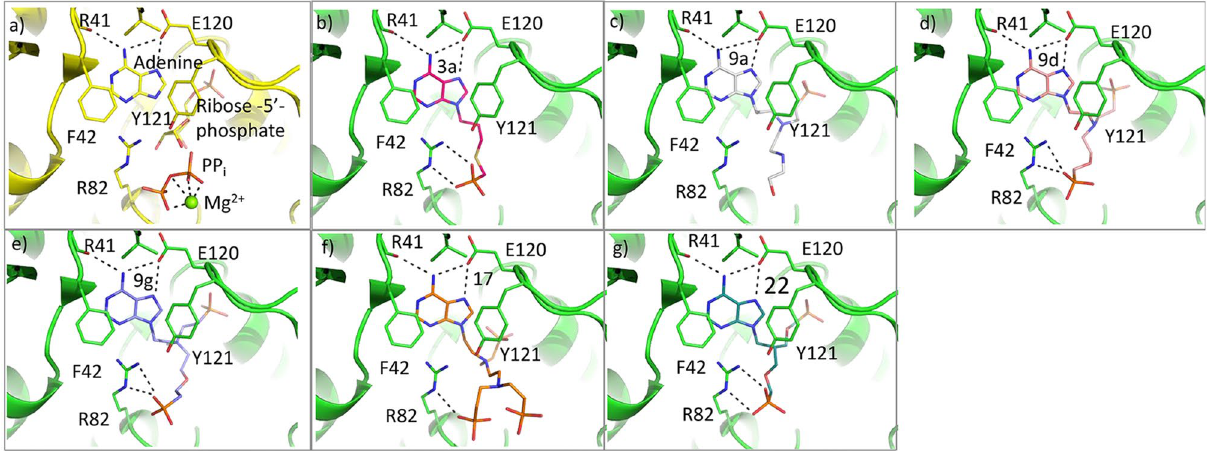
Figure 5. Active site and docking of 6 ANPs with T. brucei APRT1. ( a ) The crystal structure of the T.brucei